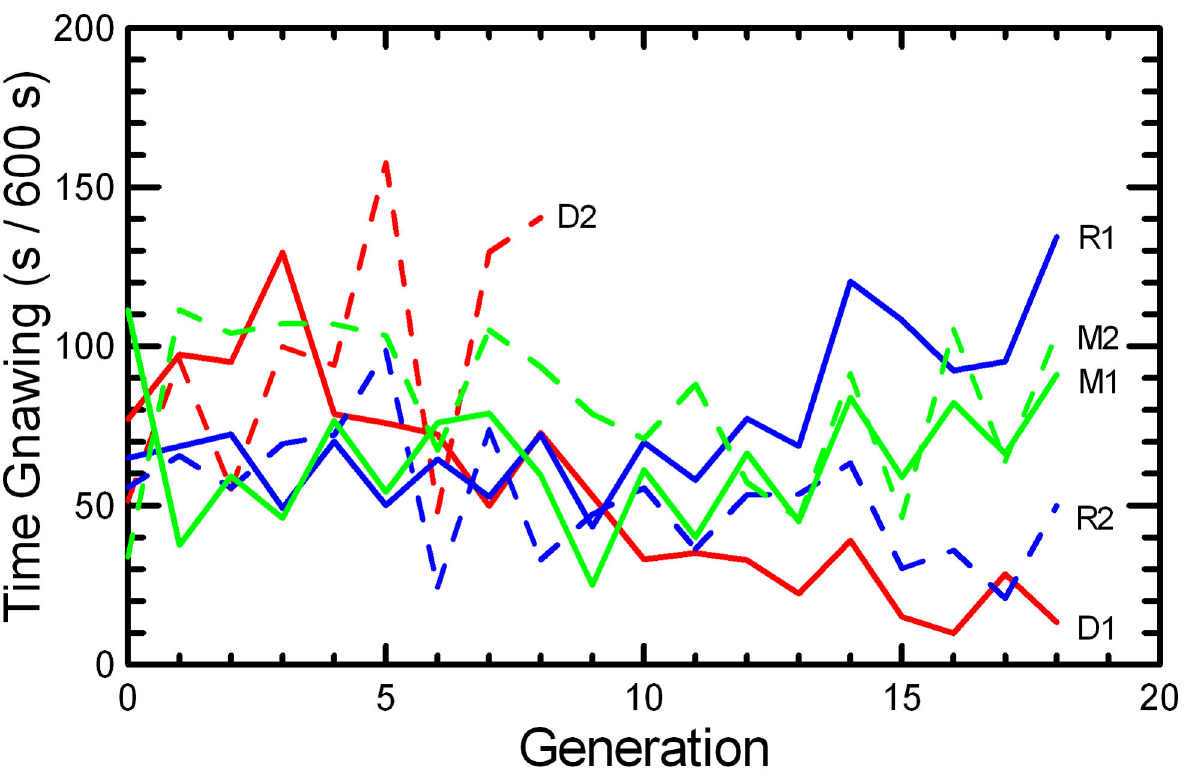
Figure 4. Mean time spent in stereotypic Flipping behavior. The mean number of seconds per 600 s observation period that mice spent in Gnawing behavior is given for the two replicates of RAN (blue), MK (green), and DOC (red) experimental populations. doi: